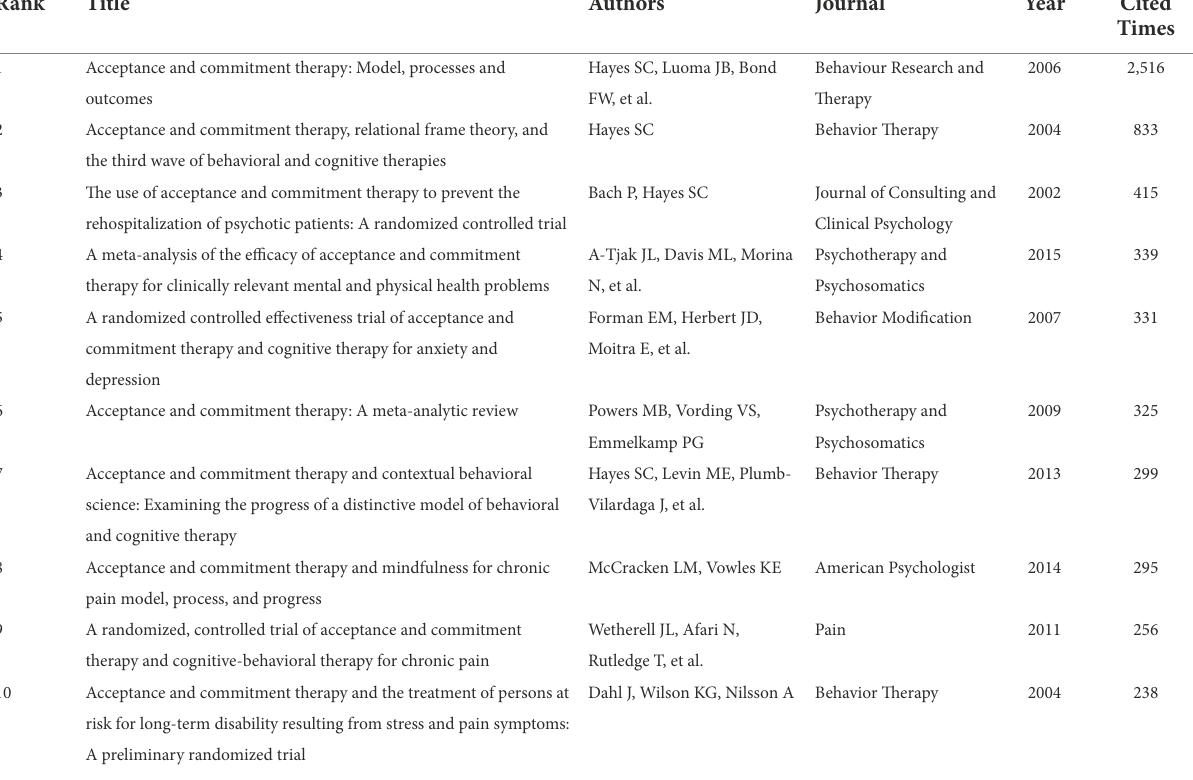
TABLE 3 The top 10 cited articles in ACT